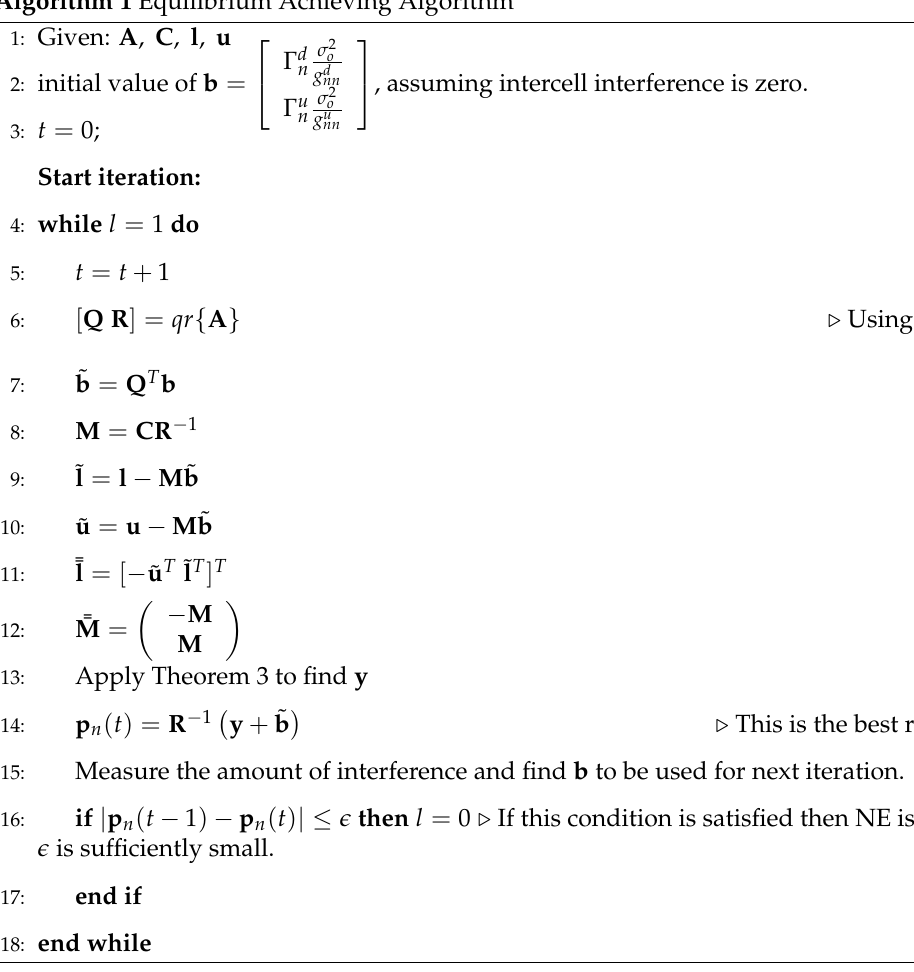
Algorithm 1 Equilibrium Achieving